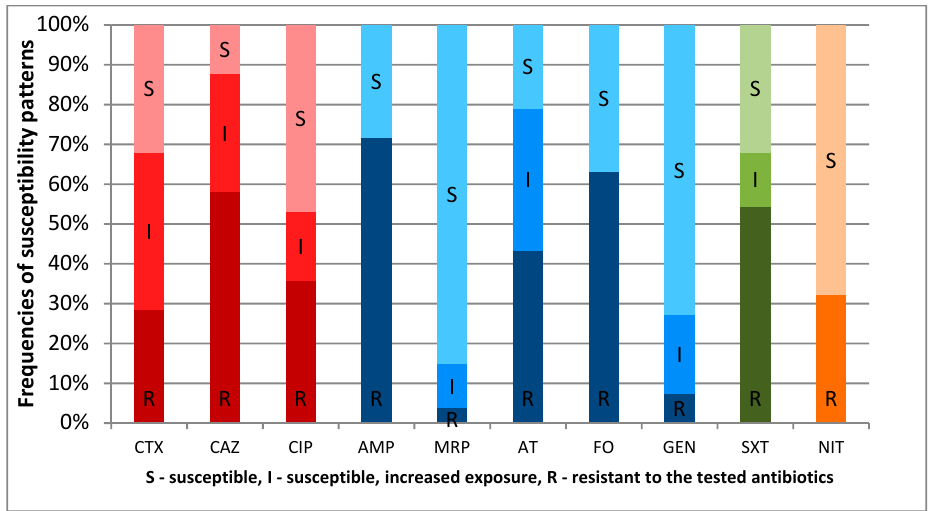
Figure 2. Susceptibility pattern of E. coli strains to critically important antimicrobials—highest priority (RED) and high priority (BLUE) and highly important (GREEN) and important (ORANGE) antimicrobials for human medicine.